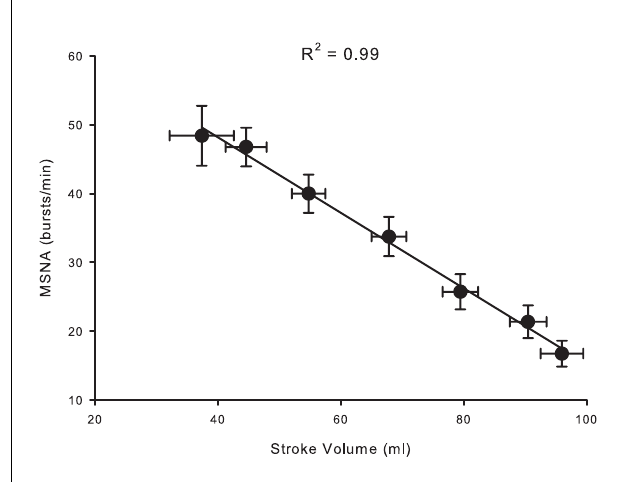
FIGURE 3 | Relationship between stroke volume (SV) and muscle sympathetic nerve activity (MSNA) during LBNP in 20 human subjects. Data modified from Ryan et al. (2011).